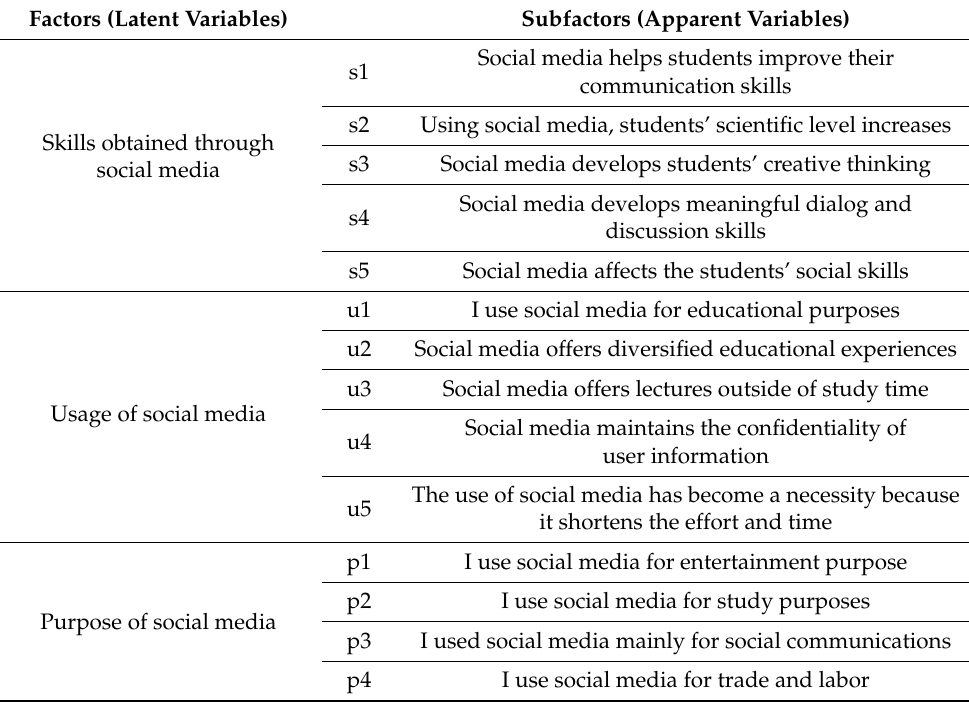
Table 3. Details of the latent and apparent